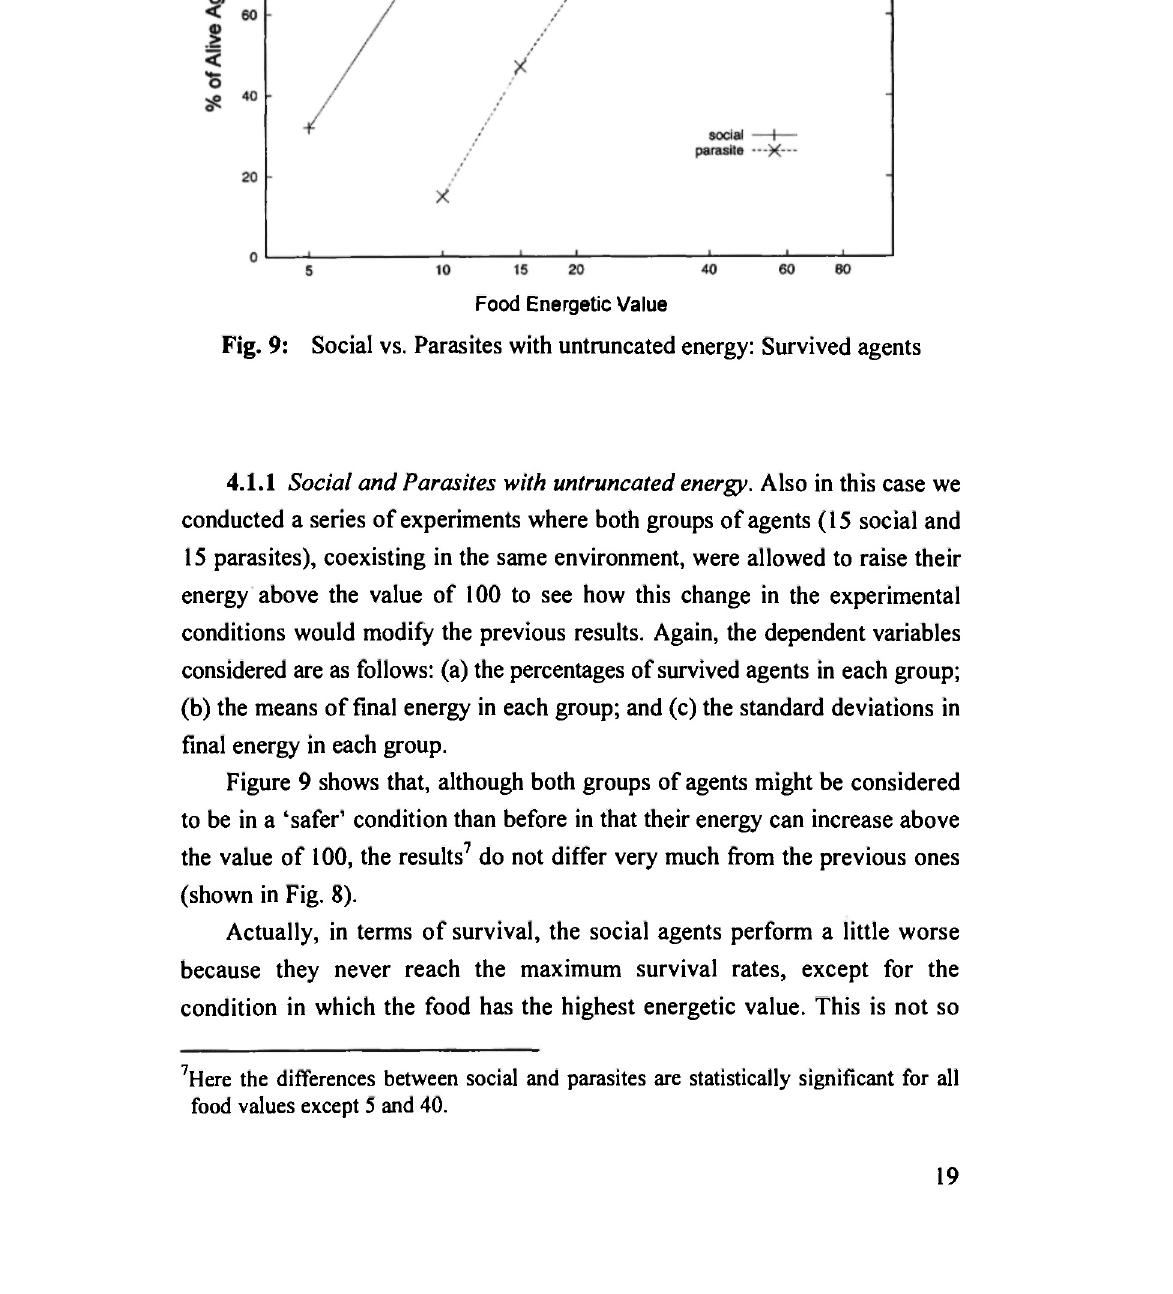
Fig. 9: Social vs. Parasites with untruncated energy: Survived agents